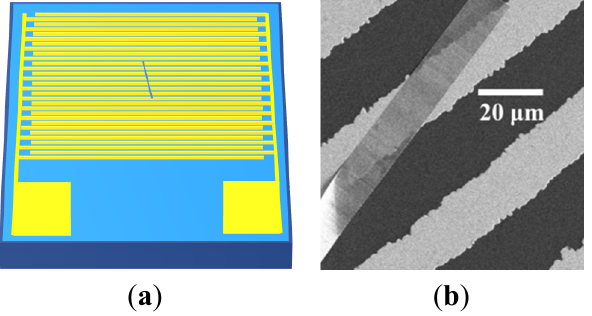
Figure 5. Diagram ( a ) and scanning electron microscope (SEM) image ( b ) of an individual Ga 2 O 3 nanobelt on Pt